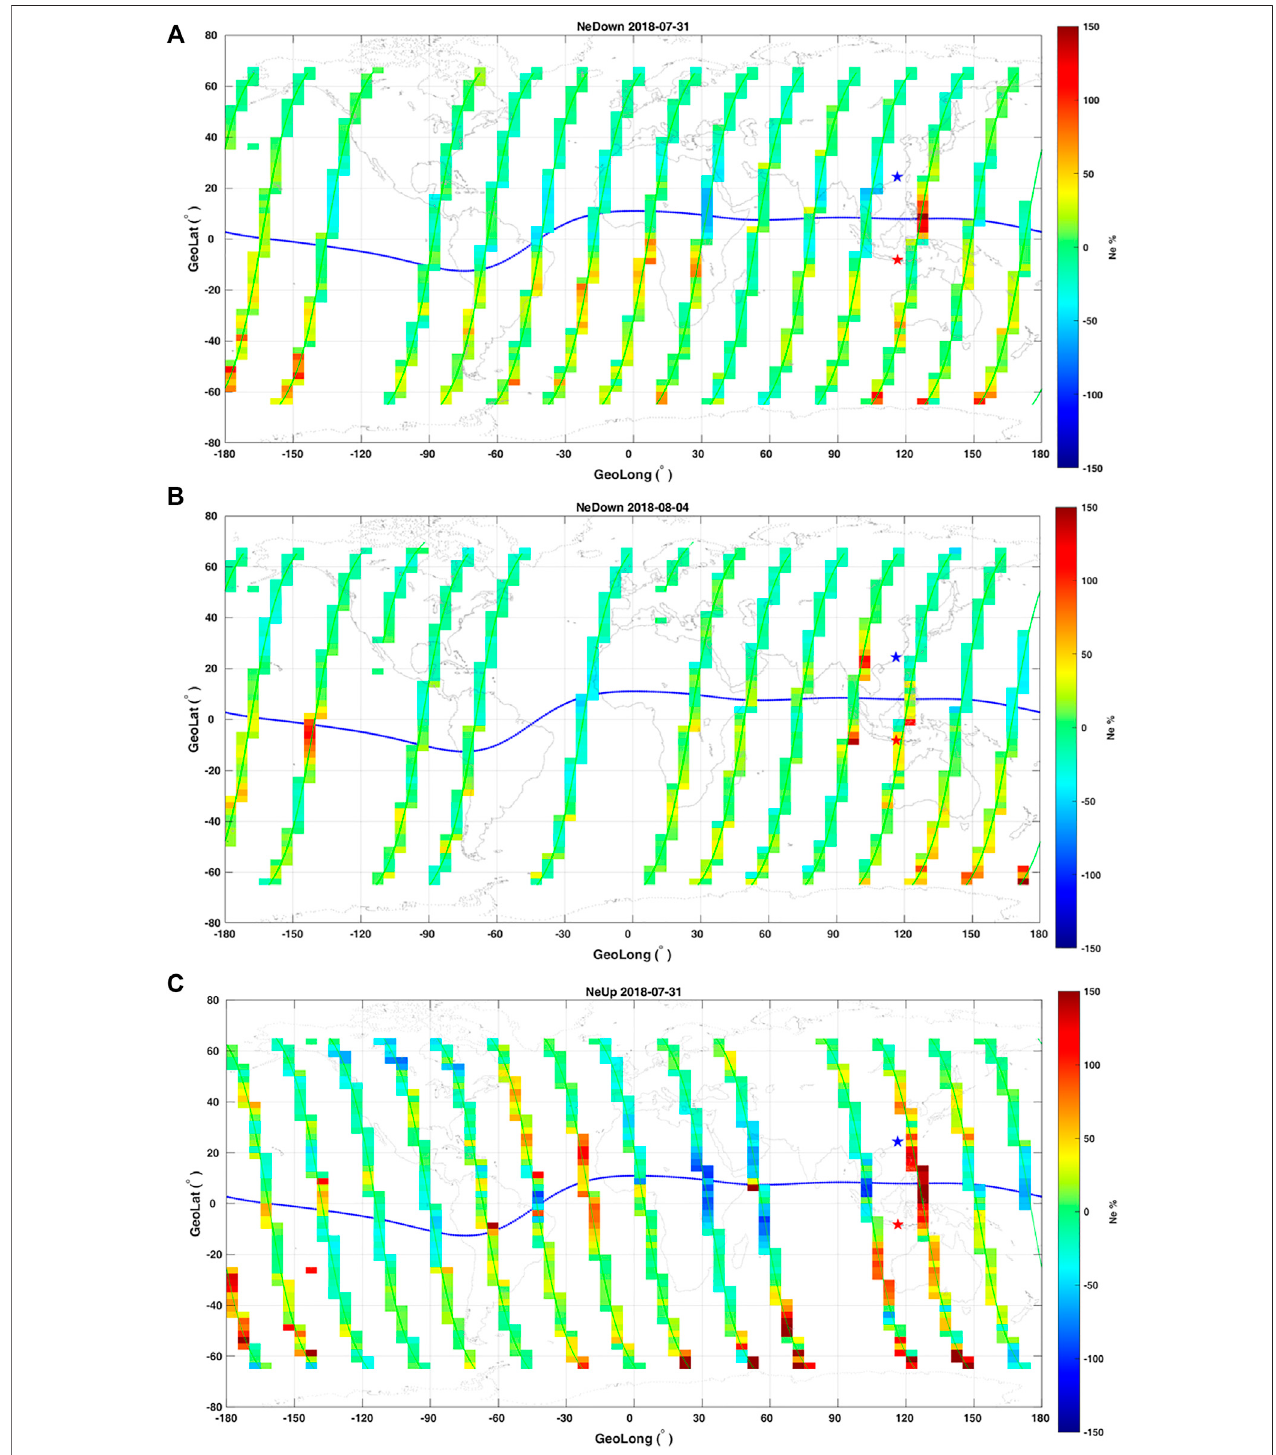
FIGURE 3 | Relative change of Ne data observed by CSES in the daytime on 31 July (A) , August 4 (B) , and in the nighttime on 31 July (C) . Blue line represents the magnetic equator. Green lines are the fl ight orbits of CSES. Red star shows the epicenter, and blue one indicates its conjugate point.